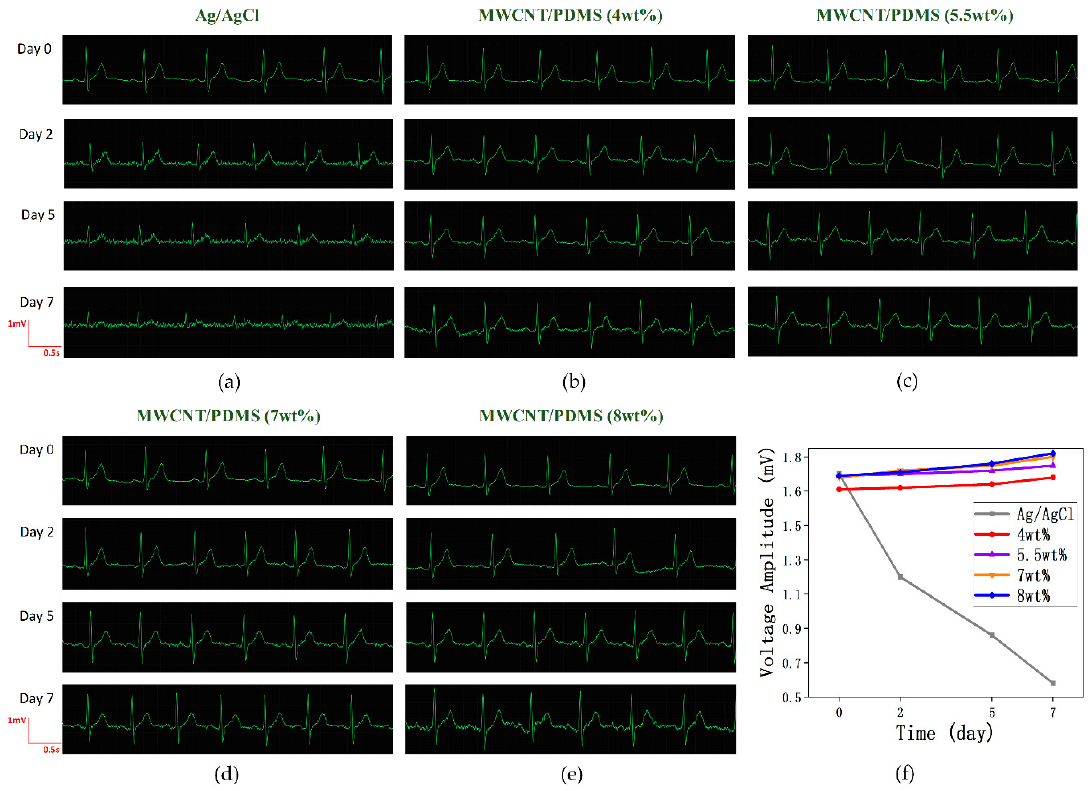
Figure 8. Comparison of long-term ECG detection with commercial Ag/AgCl electrodes and MWCNT/PDMS electrodes. ECG signals were measured using ( a ) commercial Ag/AgCl electrodes, ( b ) 4 wt%, ( c ) 5.5wt%, ( d ) 7 wt%, and ( e ) 8 wt% MWCNT/PDMS electrodes. ( f ) R-wave average amplitude as a function of time and 5 types of electrodes.